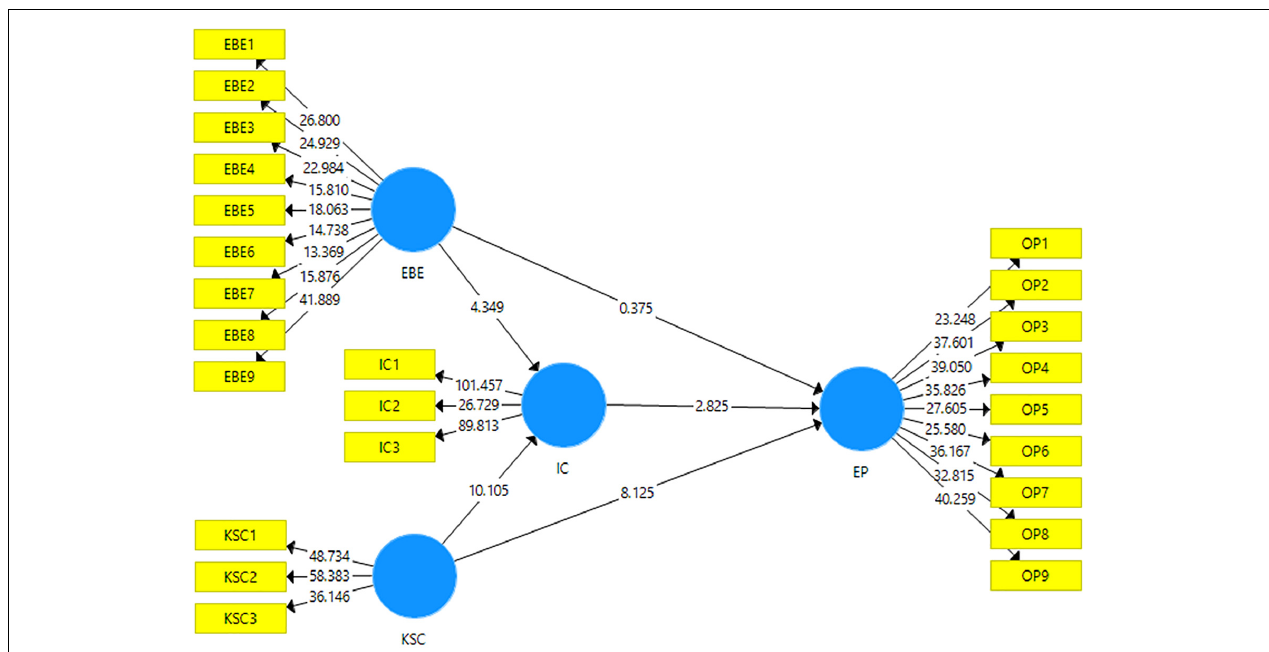
FIGURE 3 | Structural model.